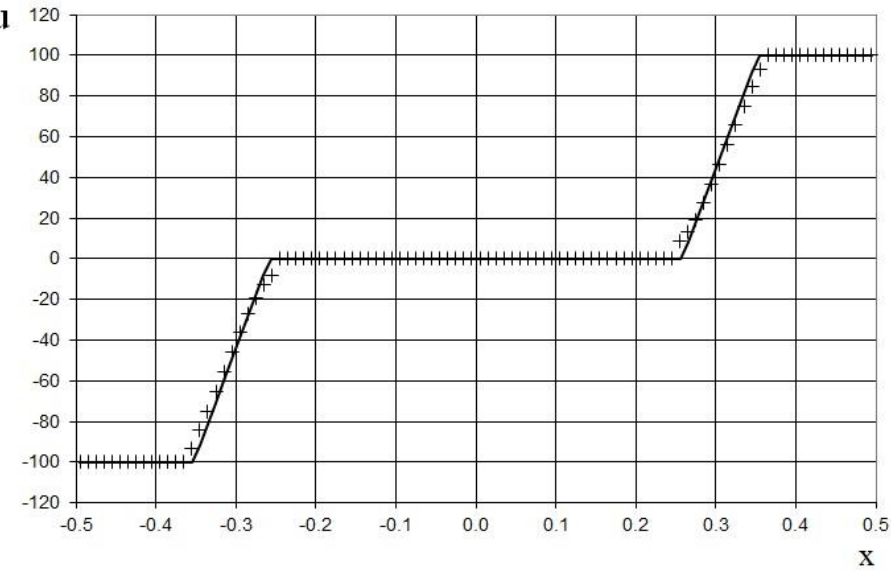
Figure 9. Velocity plot for the double expansion wave problem (47) for the adiabatic gas dynamics equations: the exact solution (line), and the present method (cross).